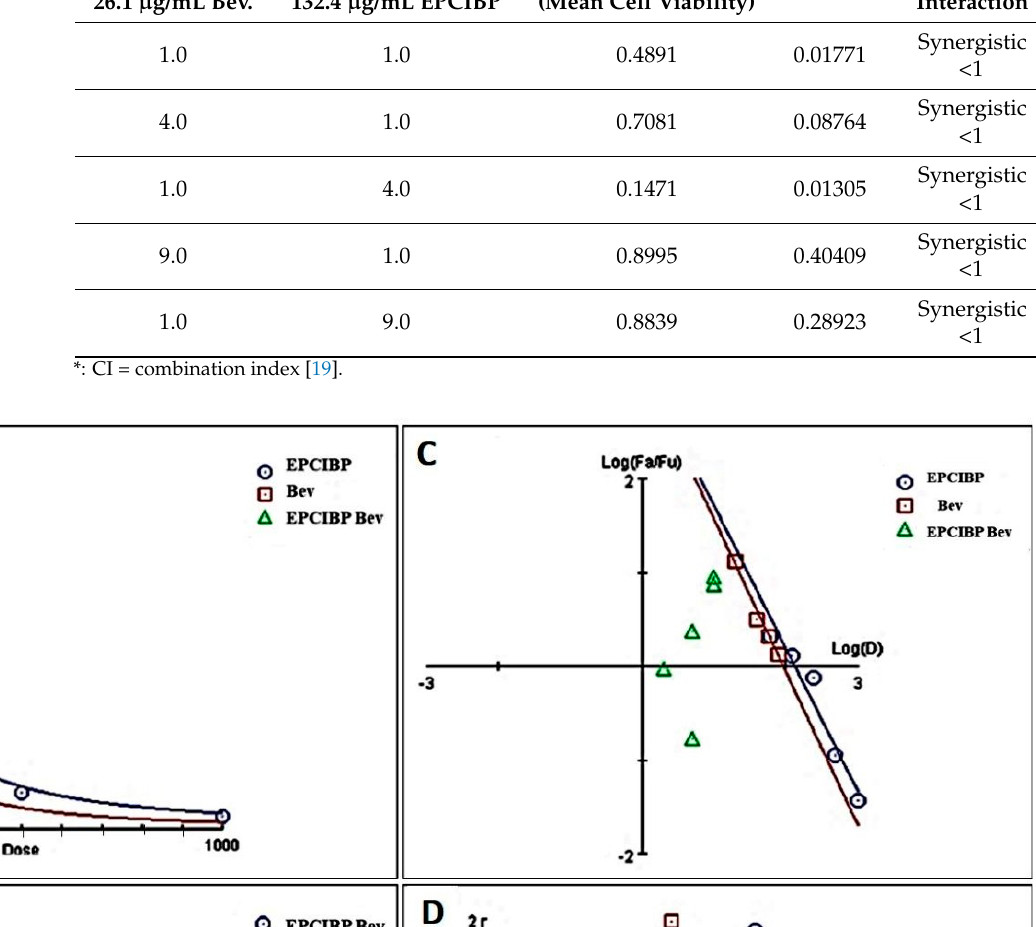
Table 2. CI data for the combined effect of Bev. and EPCIBP on A549 cells. IC50 Dose 26.1 µg/mL Bev. IC50 Dose 132.4 µ g/mL EPCIBP